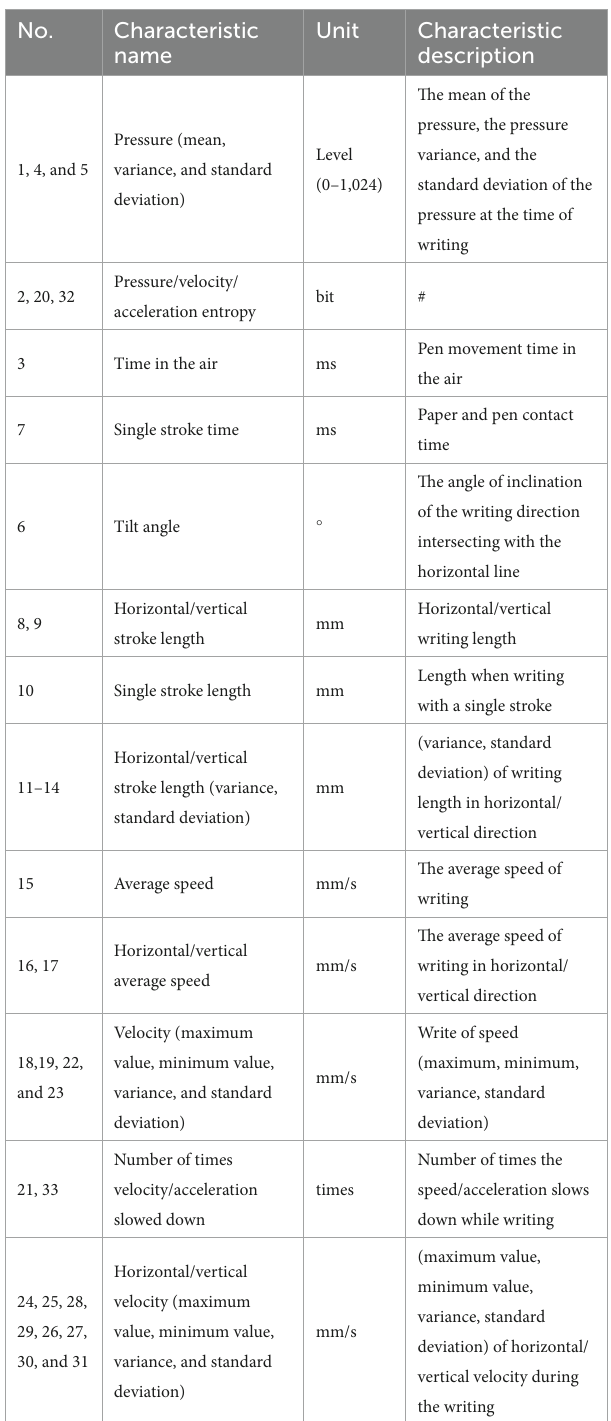
TABLE 2 List of 35 handwriting